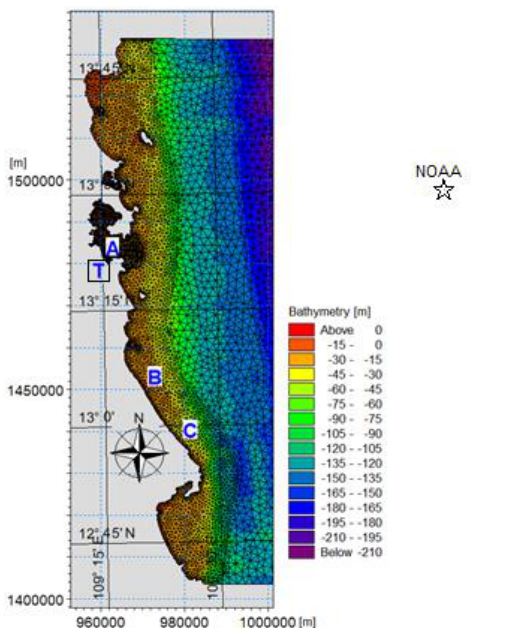
Fig. 3. Computational domain and grid with tidal (T) and wave gauging locations (A, B, C). The location for the NOAA wave data sampling data is also shown as a star